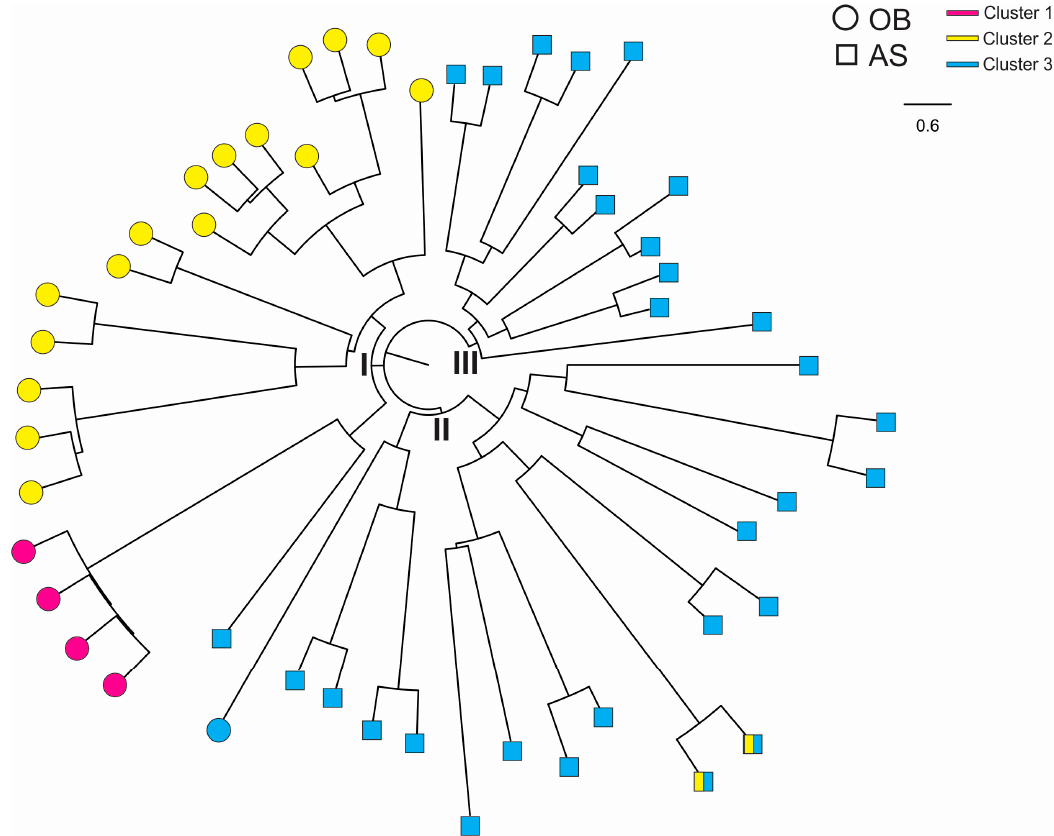
Figure 6. Neighbor-joining tree showing genetic relatedness among the P. falciparum isolates. OB, Obom (as circles) and AS, Asutsuare (as squares). Color (pink, yellow and blue) denoted the corresponding cluster for each sample (Figure 4). Samples from OB were found in clade I and samples from AS in clades II and III.